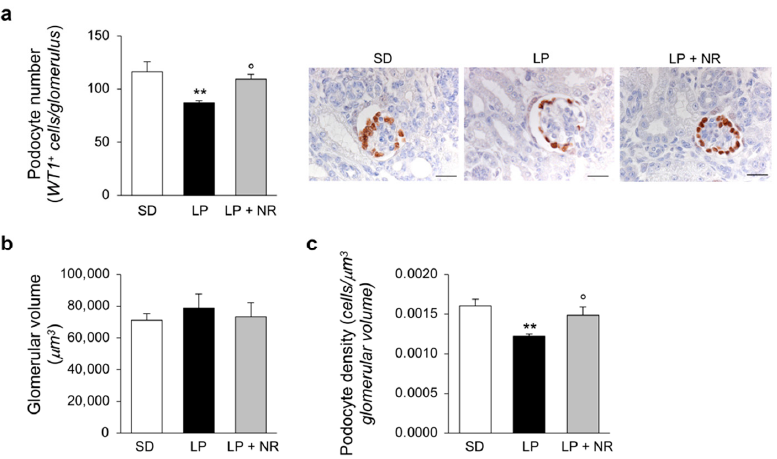
Figure 2. NR supplementation restores podocyte density in maternal LP diet offspring. ( a ) Quantification of podocyte number per glomerulus in maternal SD, LP or LP + NR offspring ( n = 4 kidneys from 4 newborn mice per group) and representative images of renal tissues immunohistochemically stained for the podocyte marker WT-1. Scale bars, 20 μ m. ( b ) Kidneys from newborn mice born to mothers fed a SD, LP or LP + NR were analyzed to quantify the glomerular volume ( n = 4 kidneys from 4 newborn mice per group) and ( c ) podocyte density ( n = 4 kidneys from 4 newborn mice per group). Results are presented as mean ± SEM and were analyzed with ANOVA with Tukey’s post hoc test. ** p < 0.01 vs. SD; ° p < 0.05 vs. LP.